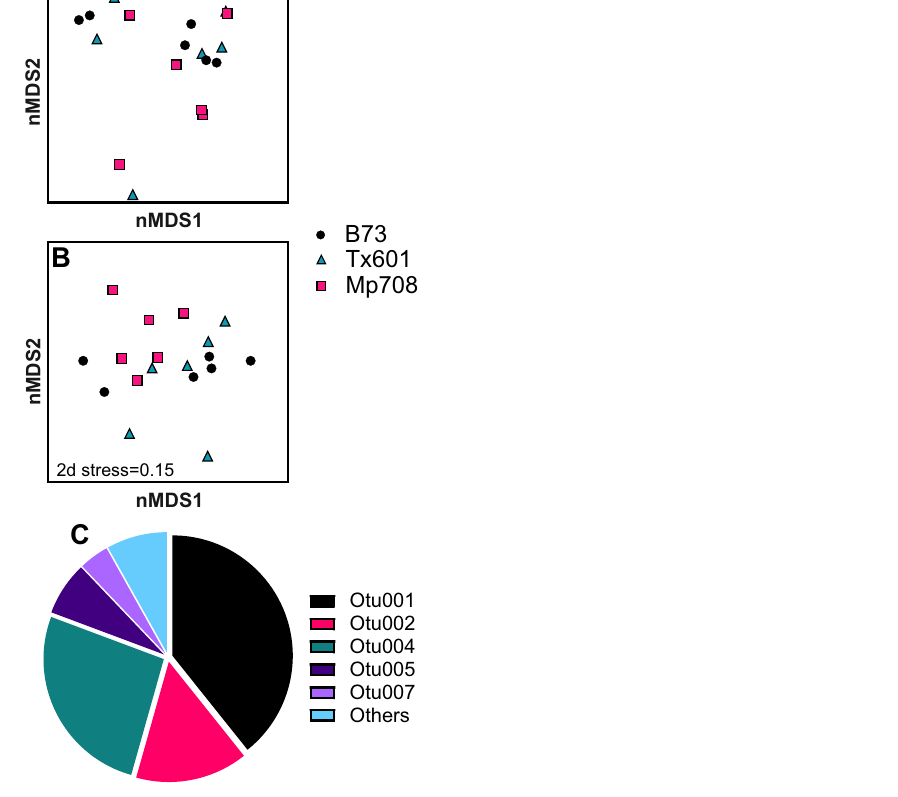
Figure 1. Influence of plant diet on fall armyworm gut microbiome structure ( A ), membership ( B ), and dominant members ( C ). There was no effect of different field-grown plants on the structure of OTUs, but there was an effect on community membership. Five OTUs comprised ~ 90% of the relative abundance across all treatments and were present in similar composition across treatments (Otu001: Unclassified Enterobacteriaceae; Otu002: Enterococcus; Otu004: Pseudomonas ; Otu005: Neorhizobium ; and Otu007: Unclassified Enterobacteriaceae). B73 and Tx601 are considered susceptible genotypes and Mp708 is resistant to fall armyworm.